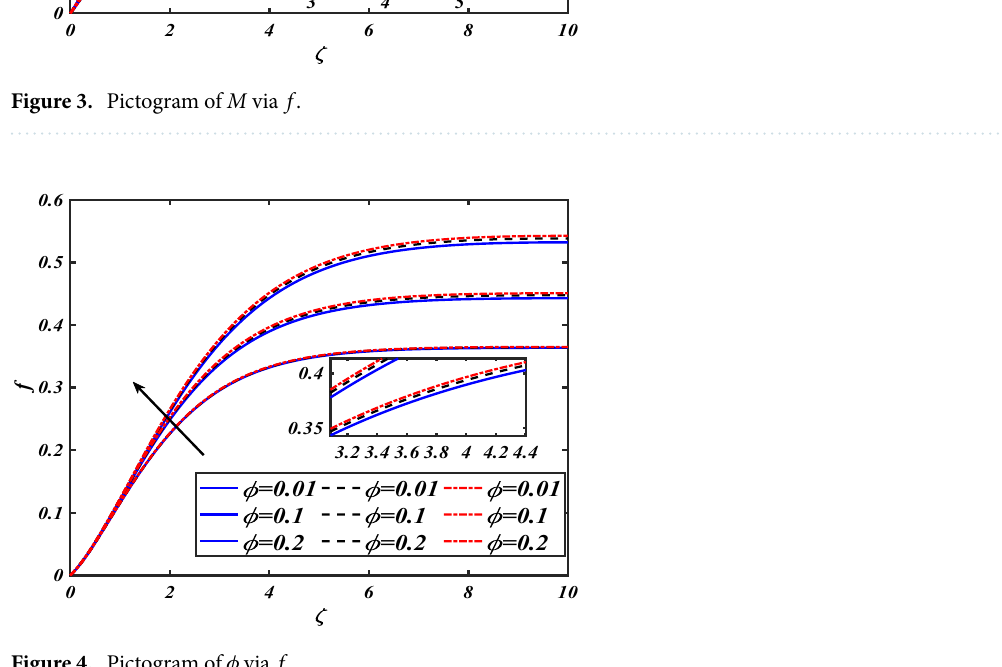
Figure 4. Pictogram of φ via f .